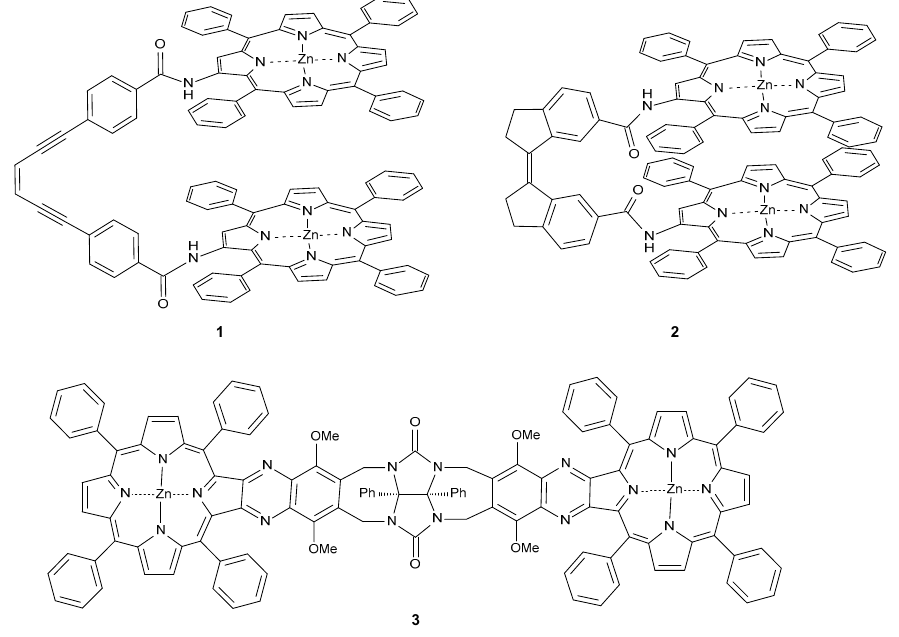
Figure 1. Bisporphyrin molecular tweezers with enediyne ( 1 ) and stiff stilbene ( 2 ) spacers, and the previously reported semi-rigid 3 with glycoluril spacer.